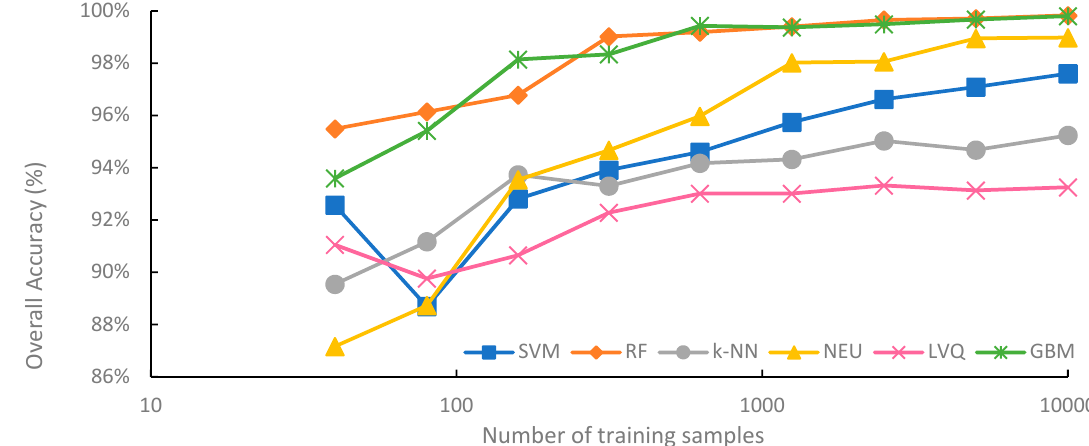
Figure 5. Overall accuracy of a single iteration of classifications (54 in total) and training set size. This series of classifications were all trained using the same training set iteration of each size. Please note that the x-axis is on a log scale.